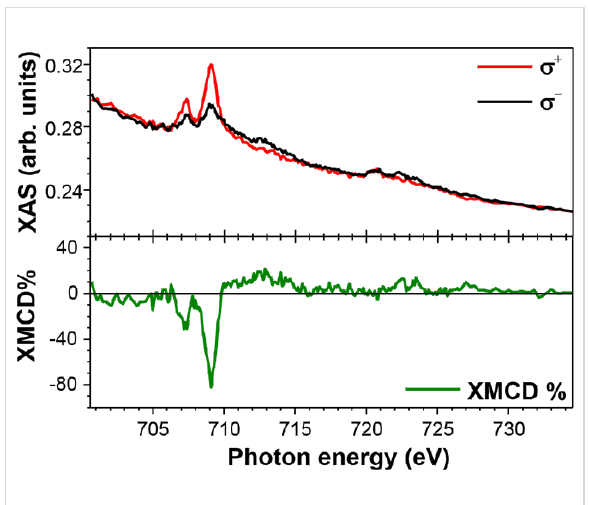
Figure 8: X-ray absorption spectra for a bulk sample of Fe(dpm) 3 acquired using the left ( σ + ) and right ( σ − ) circular polarisation (upper panel) and the derived XMCD% spectrum calculated by dividing the XMCD signal ( σ − − σ + ) by the L 3 edge jump of the isotropic spectrum ( σ − + σ + )/2 (lower